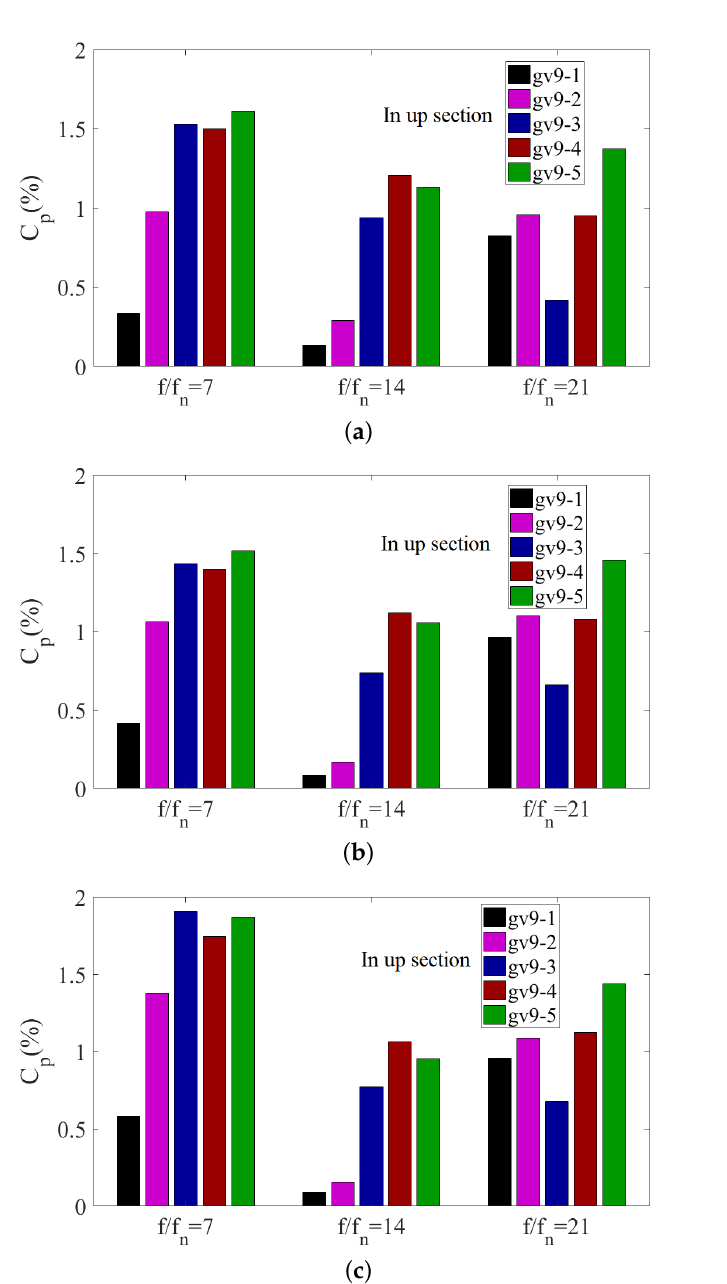
Figure 14. Amplitudes of pressure fluctuations at the monitoring points along the flow direction in guide vane passage. ( a ) 60% load condition. ( b ) 86.7% load condition. ( c ) 100% load